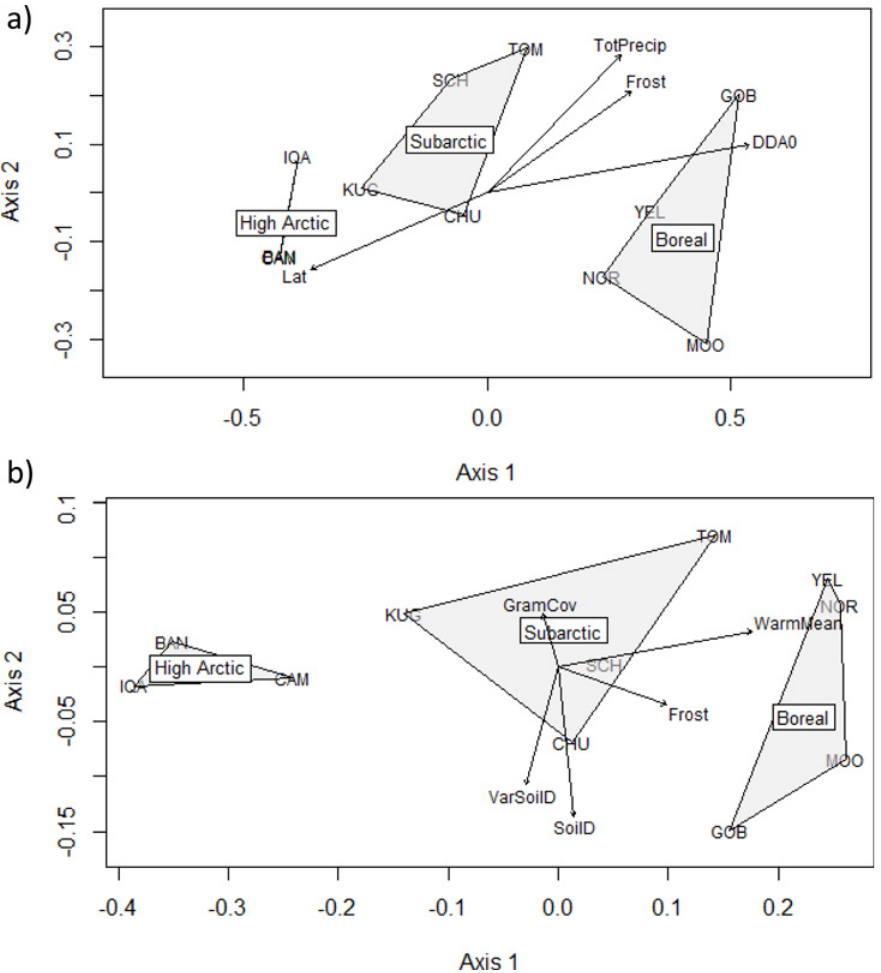
Fig 3. Non-metric multidimensional scaling ordinations showing similarities between a) species, and b) functional assemblages from at each location. Shaded polygons are used to delimit the ordination space occupied by sites contained within the same ecoclimatic zone. Spatial, climatic, and biotic variables that are significantly correlated with the assemblages are plotted on the ordination space as vectors (for clarity, non-significant variables are omitted, and only the most important temperature-related variable is included for each ordination); the length of the vector indicates the strength of the correlation. (HAZ has been omitted as an outler from both ordinations, as it contains only one, uncommon